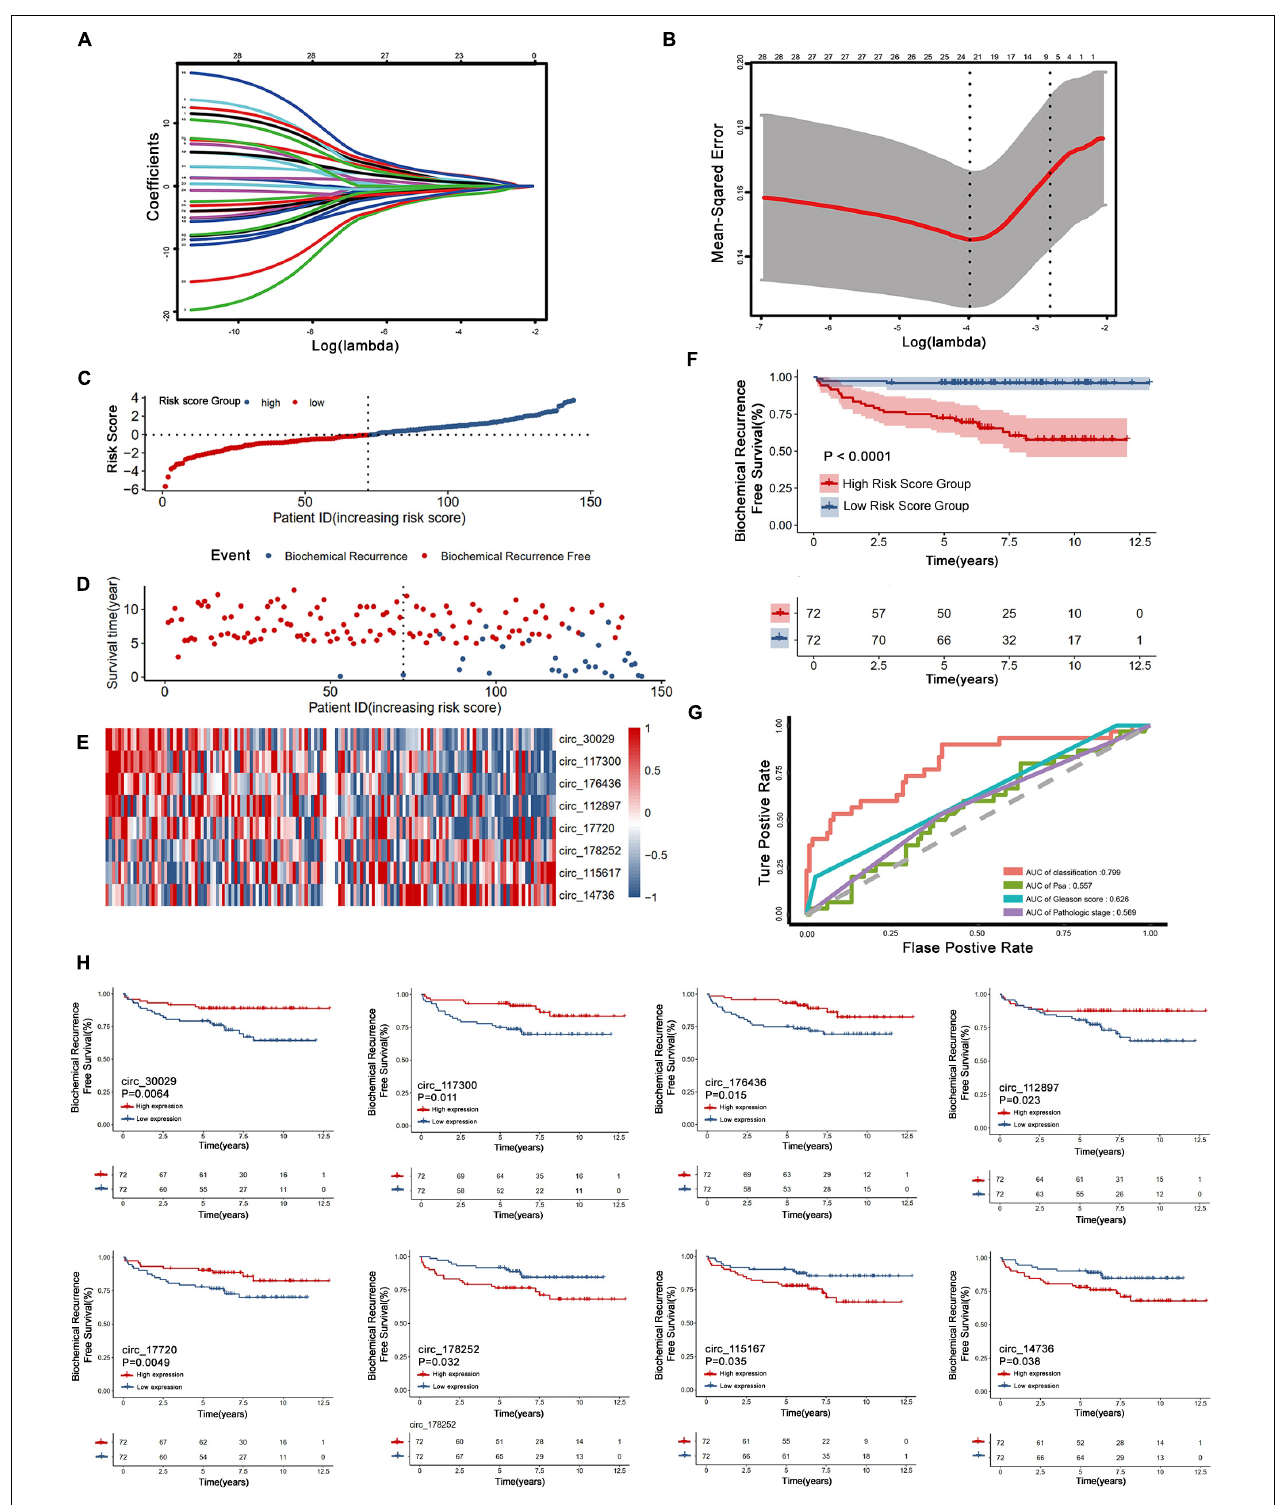
FIGURE 3 | Construction and assessment of the eight circRNAs signature associated with biochemical recurrence by LASSO regression. (A) Process of variable selection in LASSO regression with 10-fold cross-validation. (B) Confidence interval in every lambda of LASSO regression. (C–E) circRNA predictor-score analysis of 144 PCa patients. The horizontal axis represents the 144 patients. Heatmap of circRNA expression level. (F) Biochemical recurrence analysis for the classifier. (G) Time-dependent ROC analysis curve for the classifier and clinical factors. (H) Kaplan-Meier estimates of eight circRNAs signature associated with biochemical